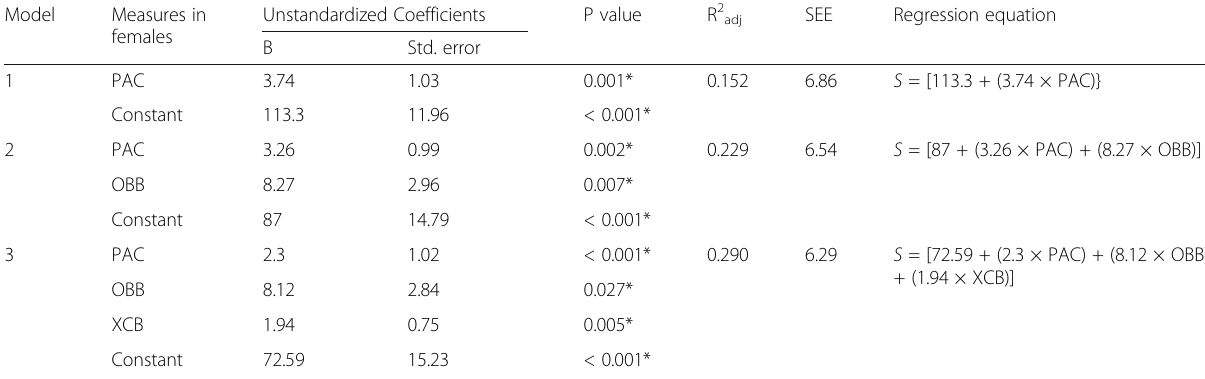
Table 11 Multiple stepwise linear regression analysis of skull measurements for stature estimation in females ( n = 70) Model Measures in females